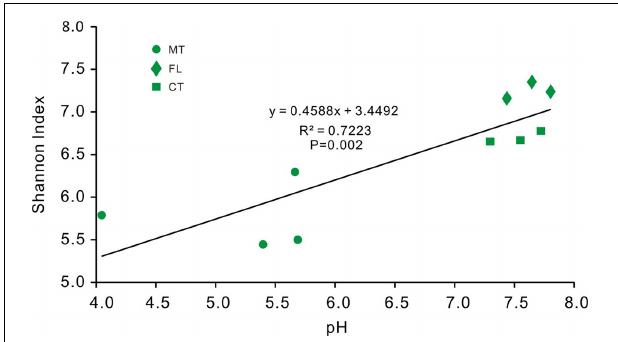
FIGURE 9 | Regression analysis between bacterial OTU diversity and pH values from overlying soil samples of Heshang Cave. Sample abbreviations are the same as previous figures, and abbreviations used are listed for Figure 1